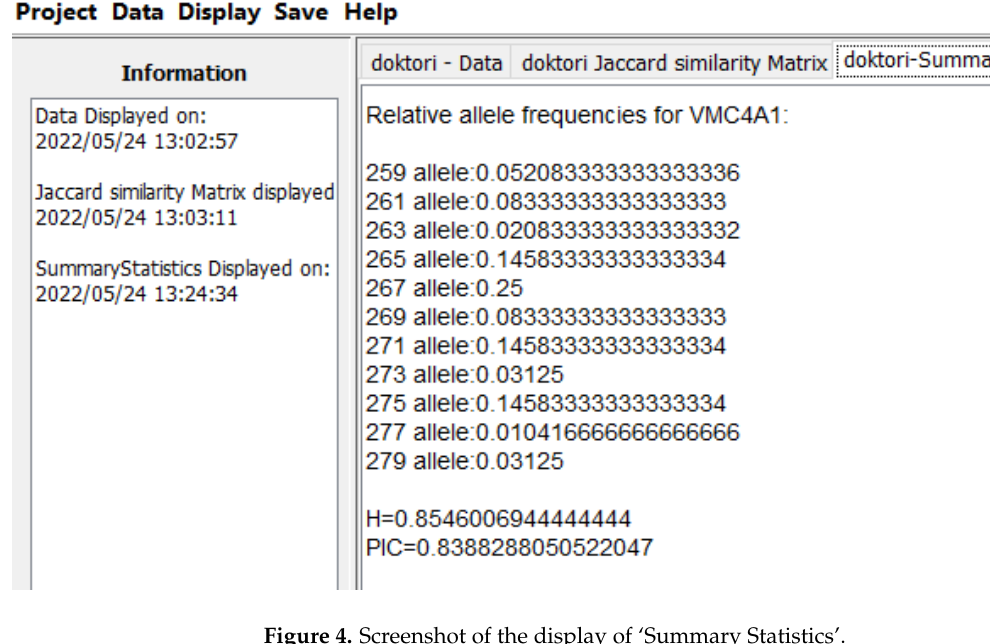
Figure 4. Screenshot of the display of ‘Summary Statistics’. (SM) [17,28] and the Czekanowski–Dice [29–31] and Ochiai [32] coefficients (Figure 5).